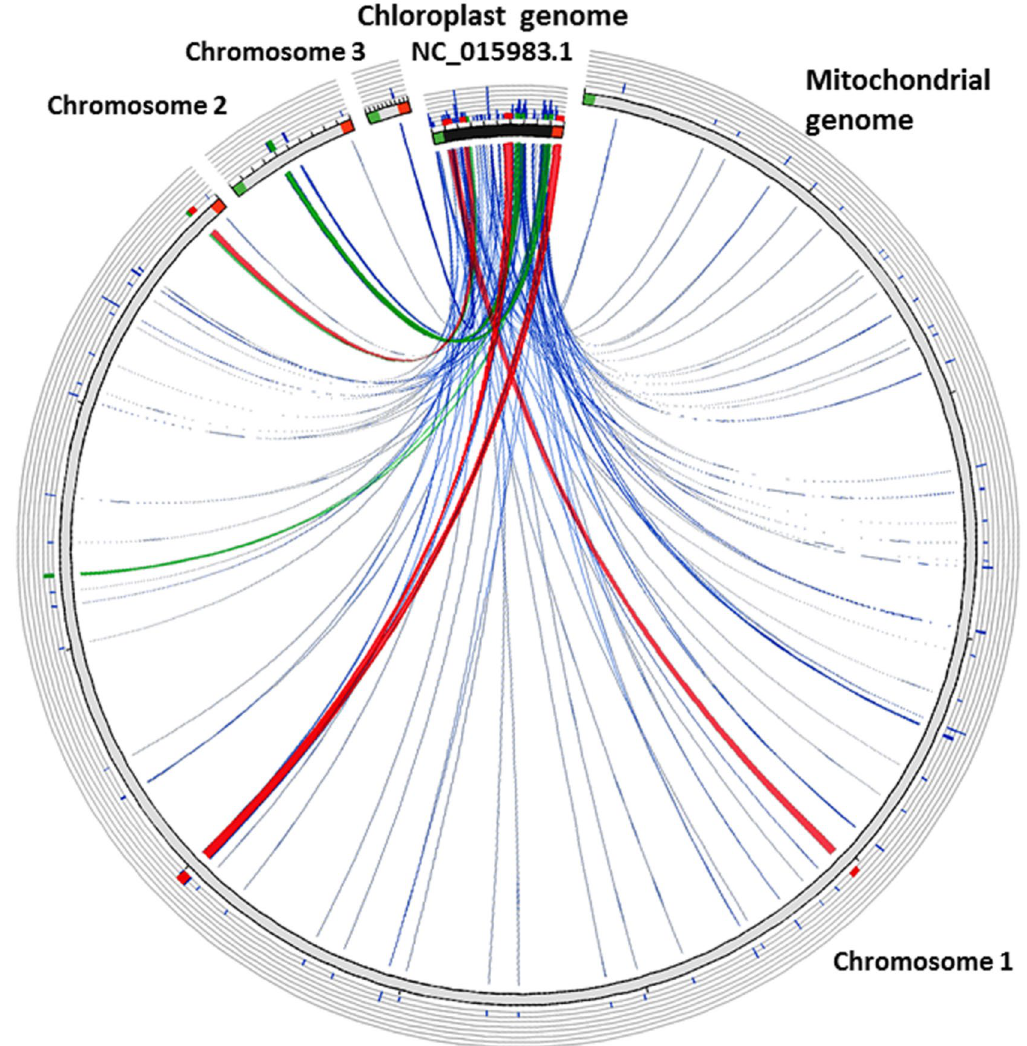
Figure 3. Transfer of sequences from chloroplast to mitochondrial genomes in C. melo.